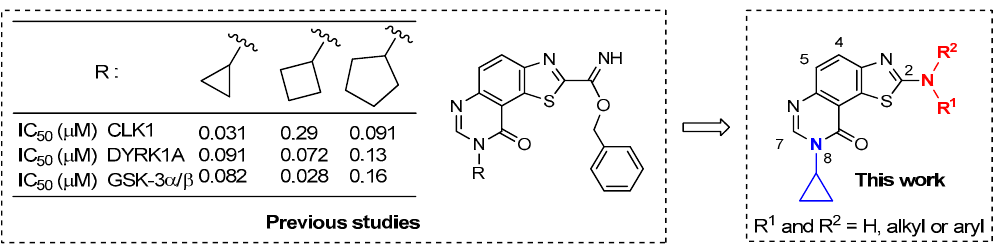
Figure 1. General formula of lead kinases inhibitors previously described [25] and new targeted molecules.